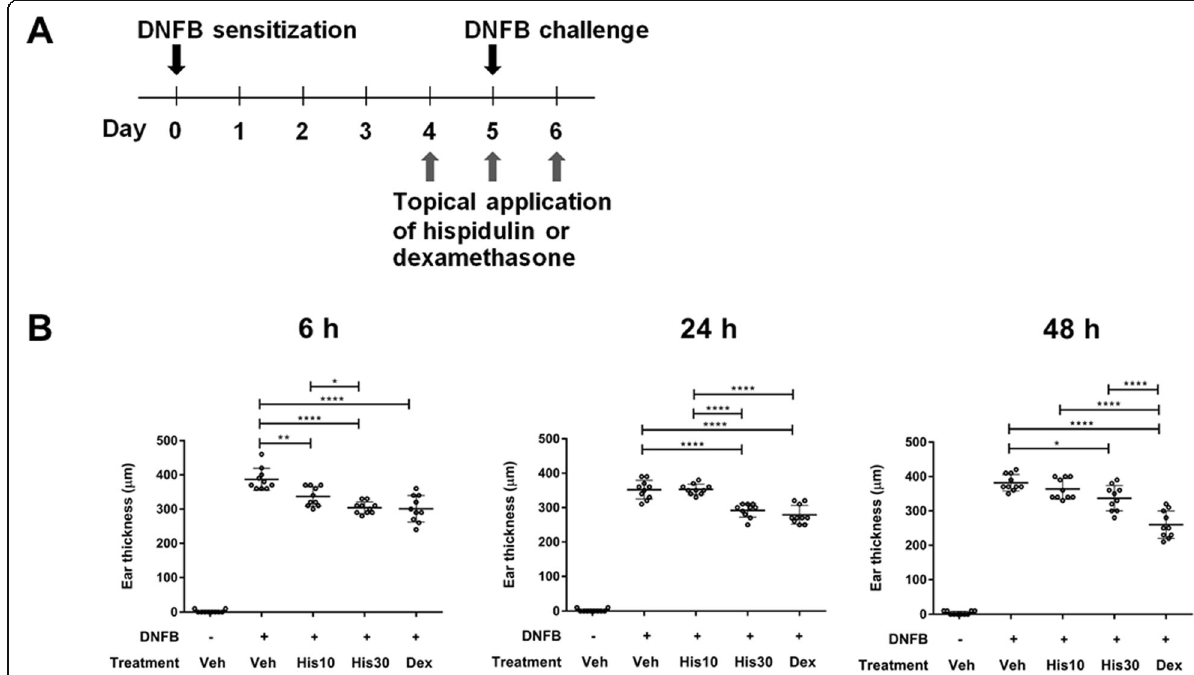
Fig. 1 Attenuated CHS responses by hispidulin treatment. a The experimental design for induction of CHS as mentioned in Materials and Methods. Hispidulin at concentrations of either 10 or 30 μ g/ear (His10 and His30) or 30 μ g/ear dexamethasone (Dex) was applied to both ears once daily on days 4 – 6. Mice applied with vehicle (Veh) alone were used as a non-sensitized control. b Measurement of ear thickness. Thickness was measured using a Vernier caliper at 6-, 24-, and 48-h post-challenge. All values are presented as mean ± standard deviation ( n = 5; * p < 0.05, ** p < 0.01, *** p < 0.001)